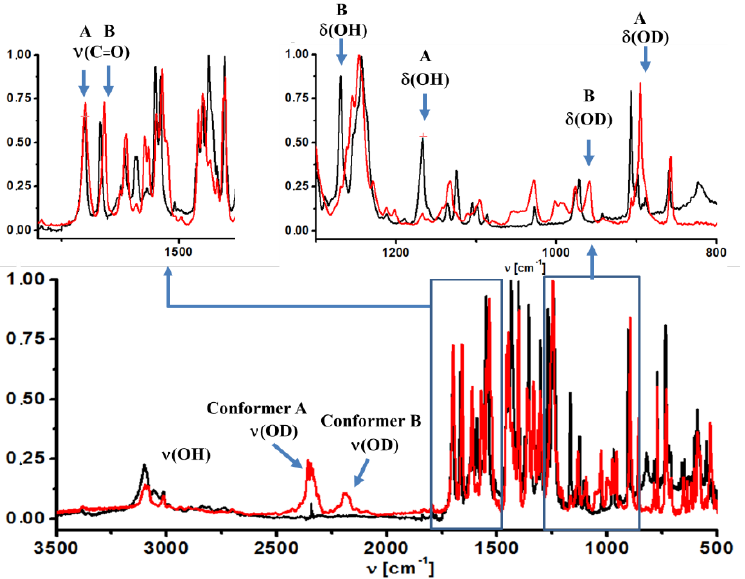
Figure 4. Matrix isolation IR spectra (in Ar) of 5-chloro-3-nitro-2-hyroxyacetophenone (black line) and its deuterated derivative (red line). and its deuterated derivative (red